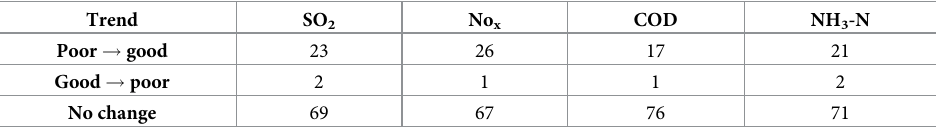
Table 3. Comparative analysis of changes in counties and cities based on the EDI and EDI with EC